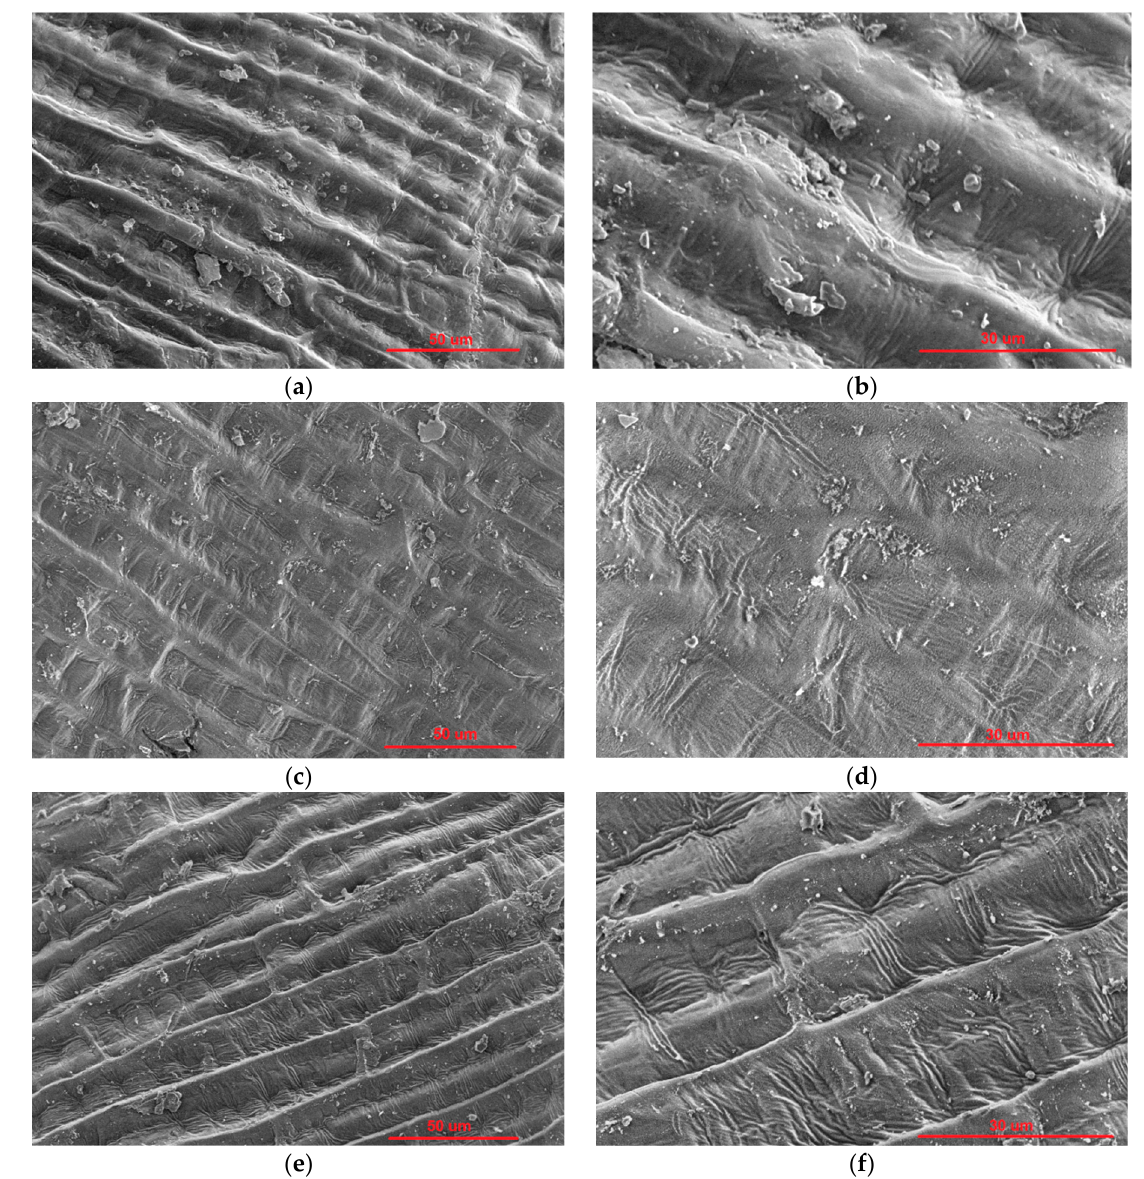
Figure 4. SEM images of Bologna wheat surface: ( a , b ) untreated; ( c , d ) E-mode treatment, 300 s; ( e , f ) H-mode treatment, 10 s. ( a , c , e ) 2000× magnification; ( b , d , f ) 5000× magnification.